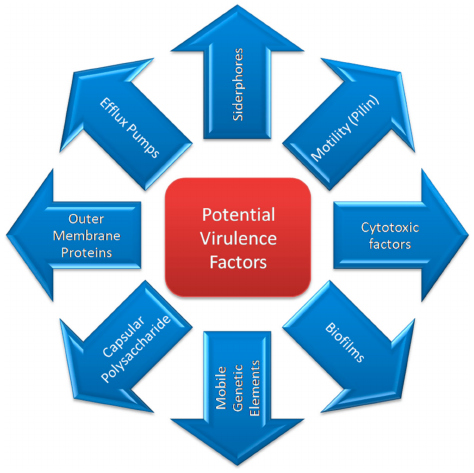
Figure 2. Potential virulence factors of A. baumannii